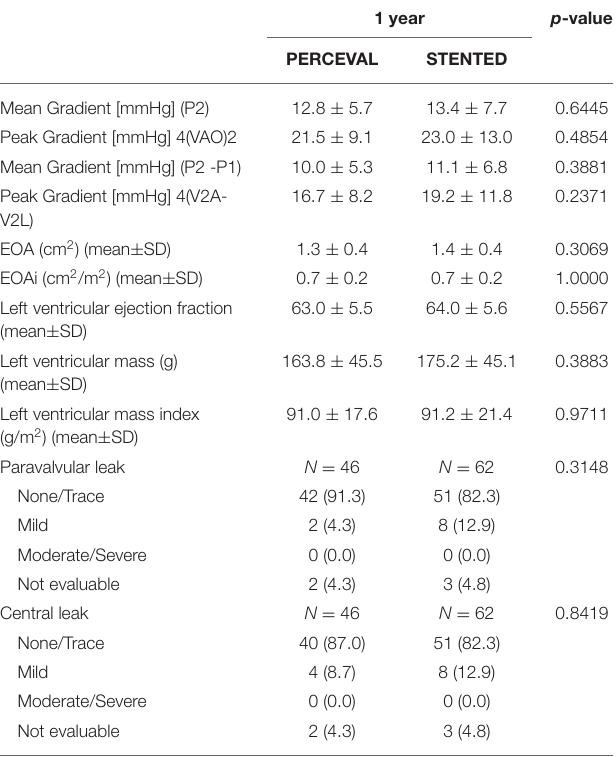
TABLE 5 | Hemodynamic data up to 1-year visit (core-lab